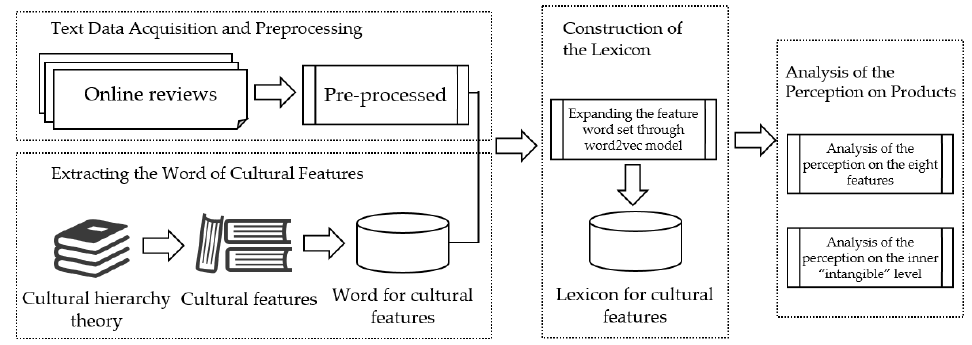
Figure 1. The framework for analyzing consumers’ perceptions based on online reviews and cultural hierarchy theory.